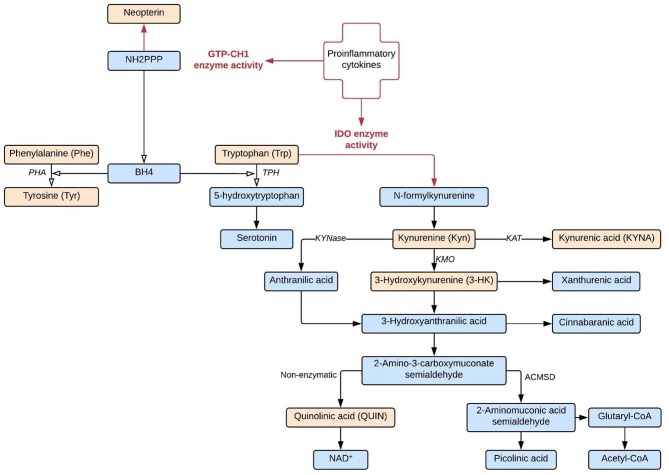
IDO and GTP-CH1 neuroendocrine pathways. Both IDO and GTP-CH1 neuroendocrine pathways are upregulated by proinflammatory cytokines. Biological compounds indicated in orange are included as biomarkers in this study.